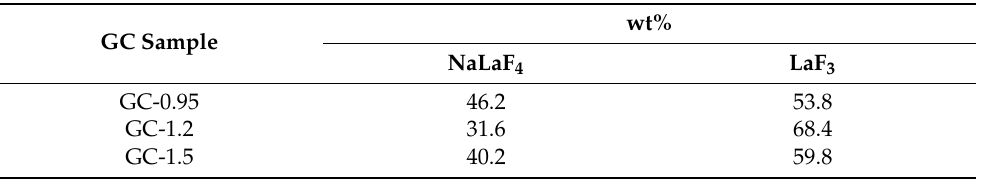
Table 2. Relation of NaLaF 4 and LaF 3 phases in 80SiO 2 -20NaLaF 4 /LaF 3 GCs treated at 650 ◦ C for 1 min estimated by Rietveld refinement (normalized to